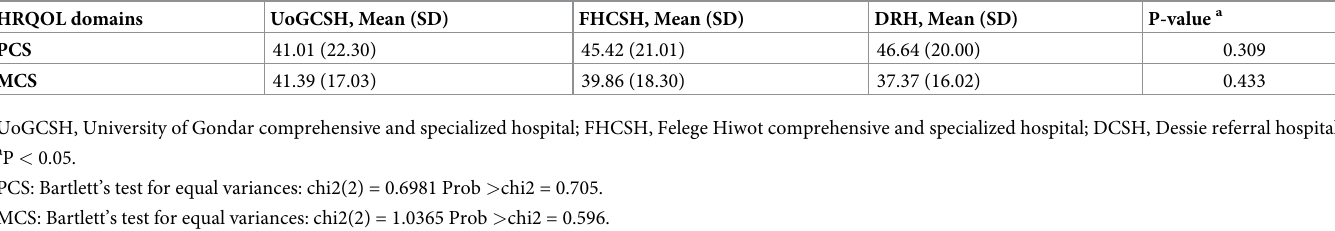
Table 2. Comparisons of HRQOL scores among the three hospitals (N = 180). HRQOL